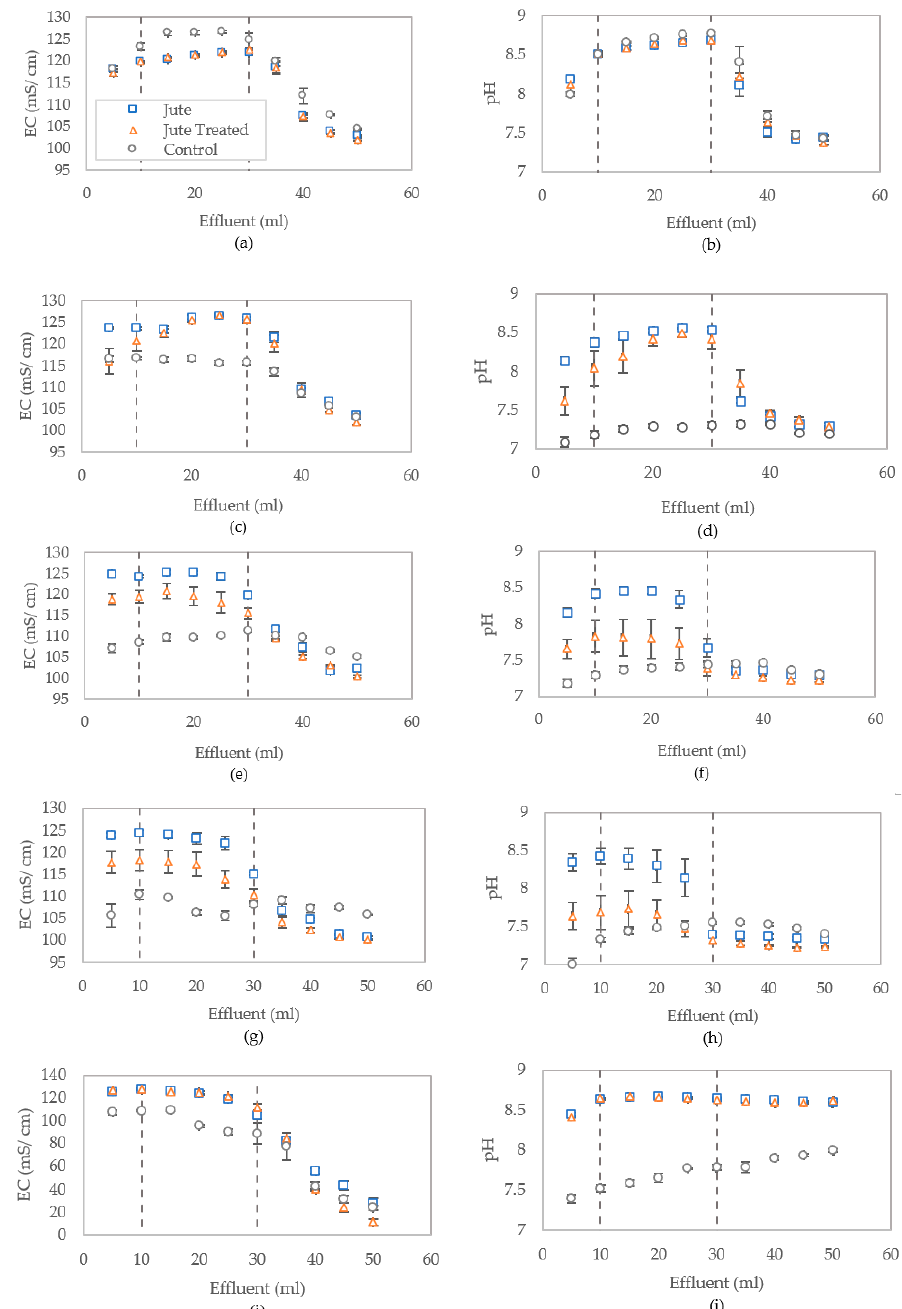
Figure 7. Conductivity and pH of columns effluent measured following treatments 1 ( a , b ), 2 ( c , d ), 3 ( e , f ), 4 ( g , h ) and 5 ( i , j ), with error bars showing standard deviations of triplicates.